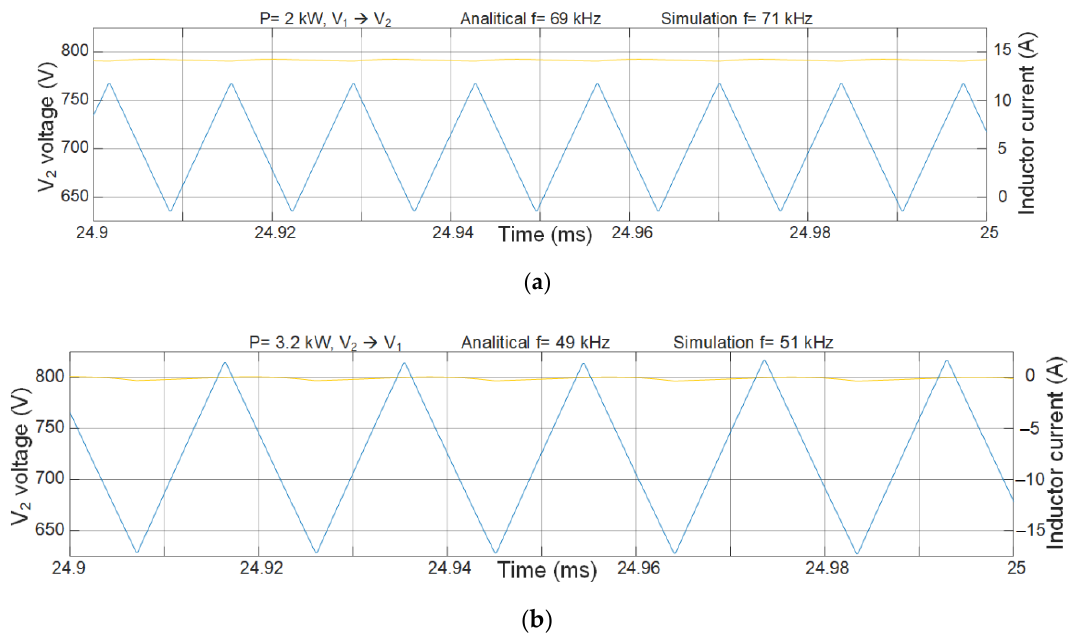
Figure 11. Simulation results showing the switching frequency on QSW-ZVS for different power. ( a ) p = 2 kW flows from V 1 to V 2 . ( b ) p = 3.2 kW flows from V 2 to V 1 . V 2 in yellow and I L in blue.